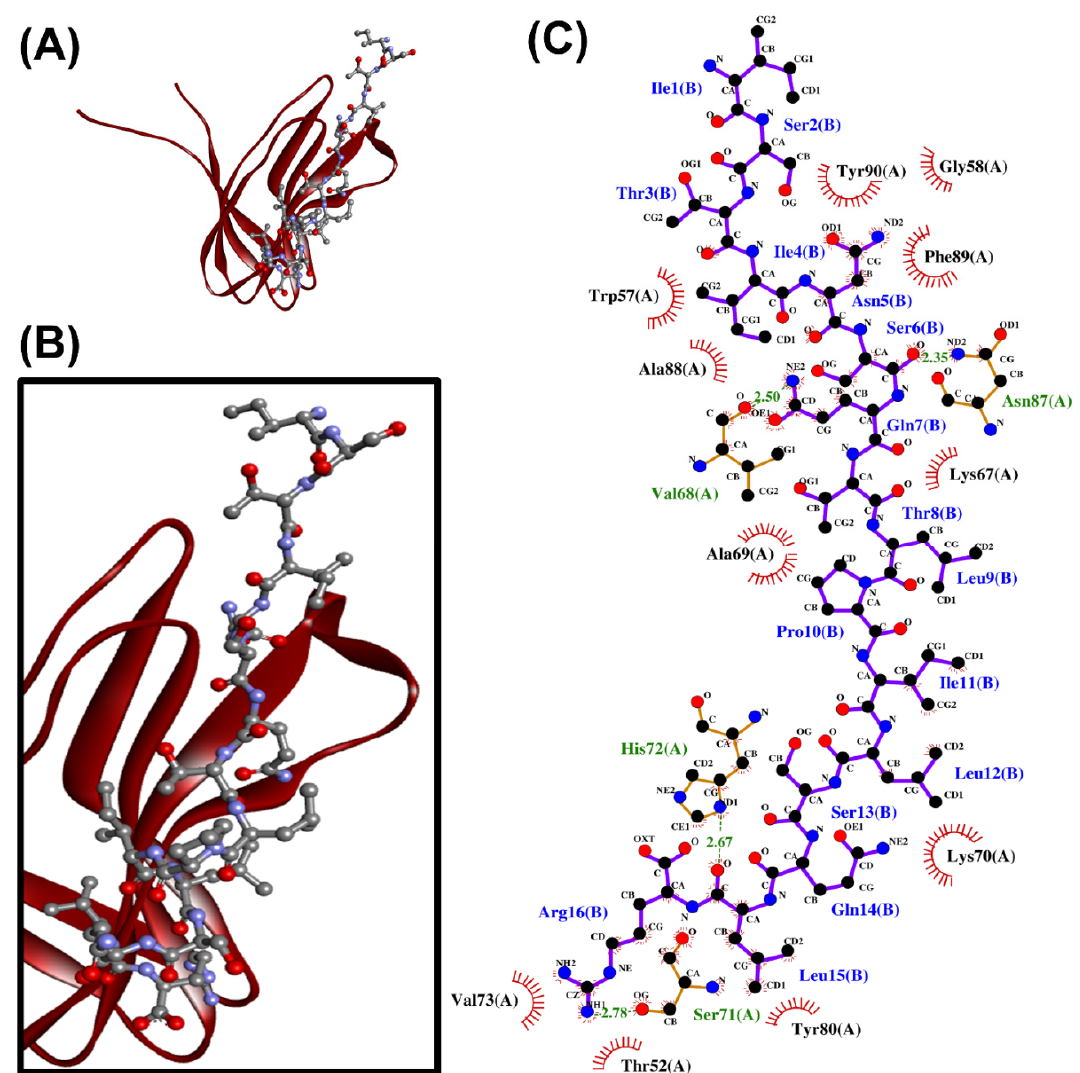
Figure 1. The ISTINSQTLPILSQLR-PirA vp docked model presented in 3D ( A , B ) and 2D ( C ) diagrams. In ( A , B ), PirA vp is shown in the cartoon in maroon; ISTINSQTLPILSQLR is presented in a ball-and-stick style. In the 2D diagram ( C ), the hydrophobic bonds and hydrogen bonds are displayed in red spoked arcs and green dashed lines, respectively.